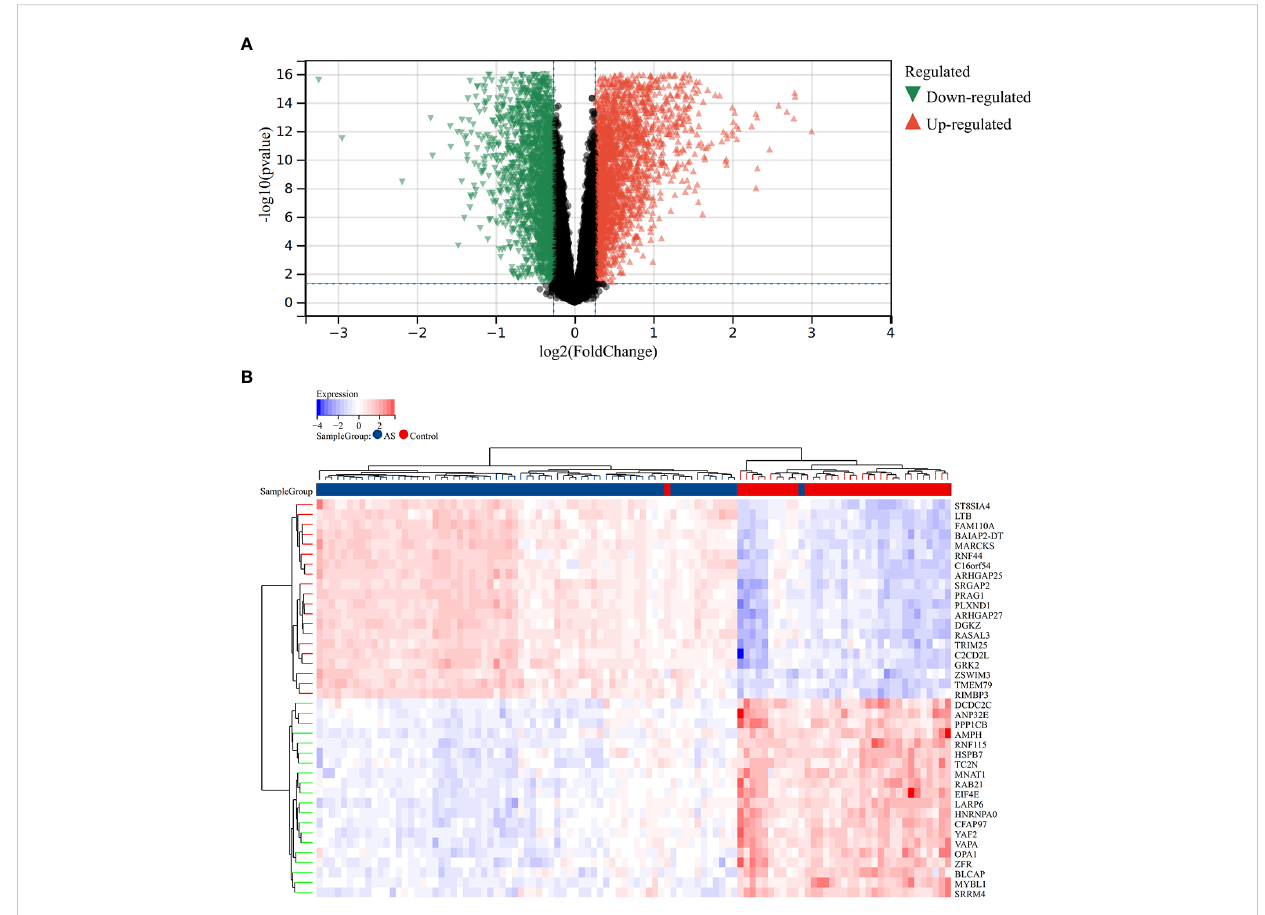
FIGURE 2 Different expression genes between AS and control groups. (A) Red and green represent DEGs with signi fi cantly higher and lower expression level in AS groups, respectively. (B) The heatmap showed the top 20 genes that were signi fi cantly expressed in the RA and control